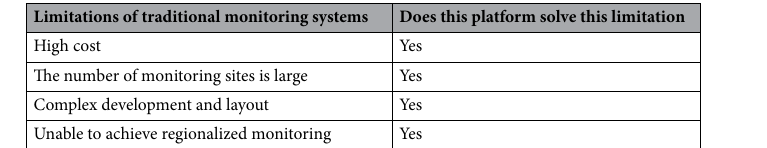
Table 2. The platform solves the limitations of the existing